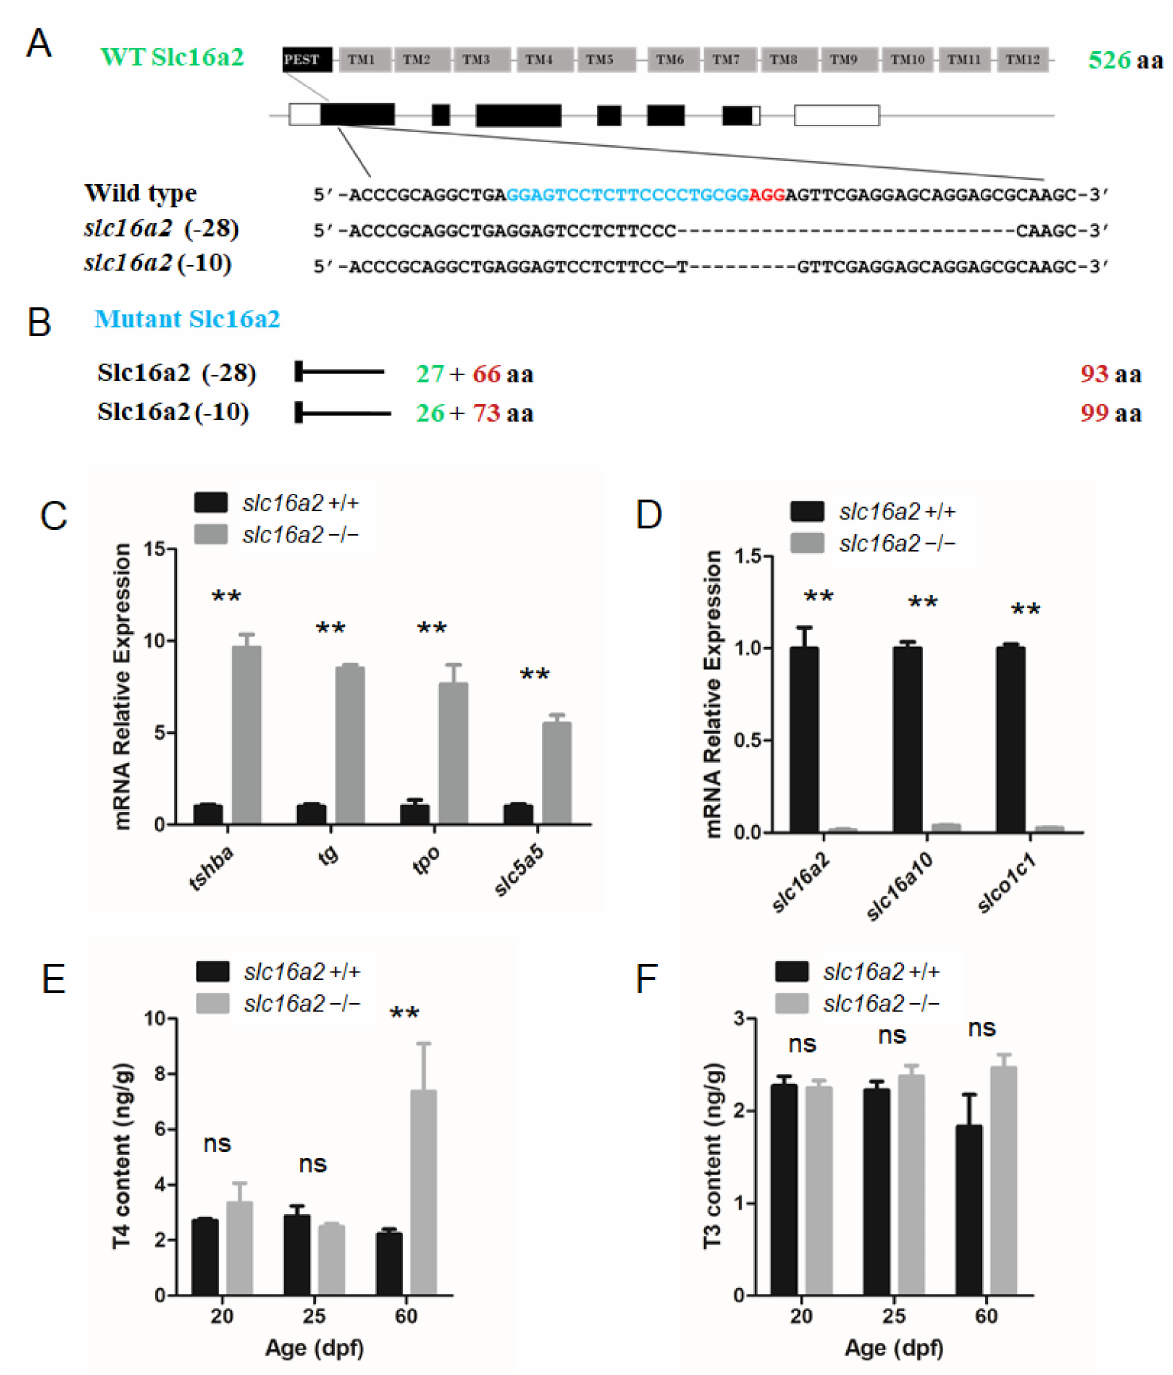
Figure 7. Generation of the slc16a2 mutant zebrafish. ( A ) Schematic illustration representing the zebrafish Slc16a2 protein (upper panel) and slc16a2 locus with the CRISPR target site on exon 1 (middle panel). Sequencing of the slc16a2 target CRISPR site in wild type, slc16a2 (-28) mutant, and slc16a2 (-10) mutant zebrafish lines are shown in the lower panel. ( B ) The predicted truncated Slc16a2 proteins resulting from premature translational termination are shown. ( C ) Quantitative RT-PCR analyses of tshba , tg , tpo , and slc5a5 expression in slc16a2 mutants and their wild-type siblings at 5 dpf. ( D ) Quantitative RT-PCR analyses of slc16a2 , slc16a10, and slco1c1 expressions in slc16a2 mutants and their wild-type siblings at 5 dpf. ( E ) Whole-body T4 contents of slc16a2 mutants and their wild-type siblings at 20, 25, and 60 dpf. ( F ) Whole-body T3 contents of slc16a2 mutants and their wild-type siblings at 20, 25, and 60 dpf. ** p < 0.01, ns: No